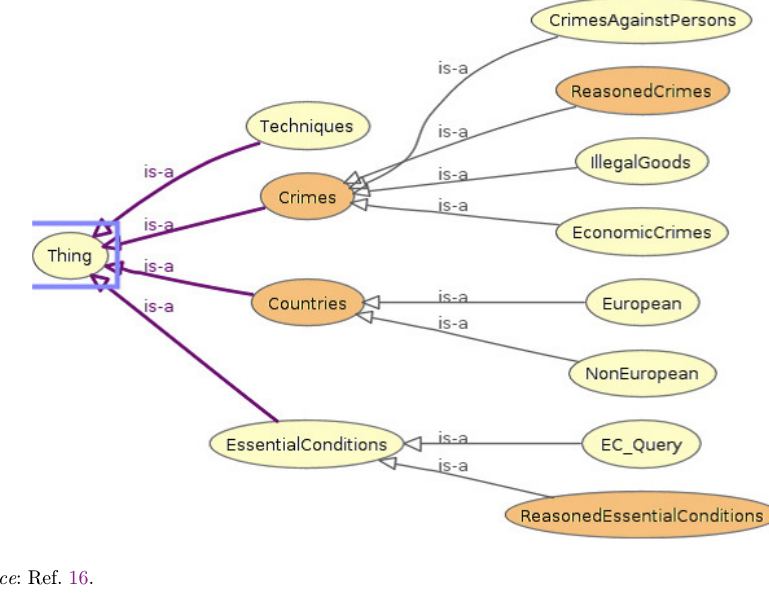
Fig. 4. Basic ELIO taxonomy based on the